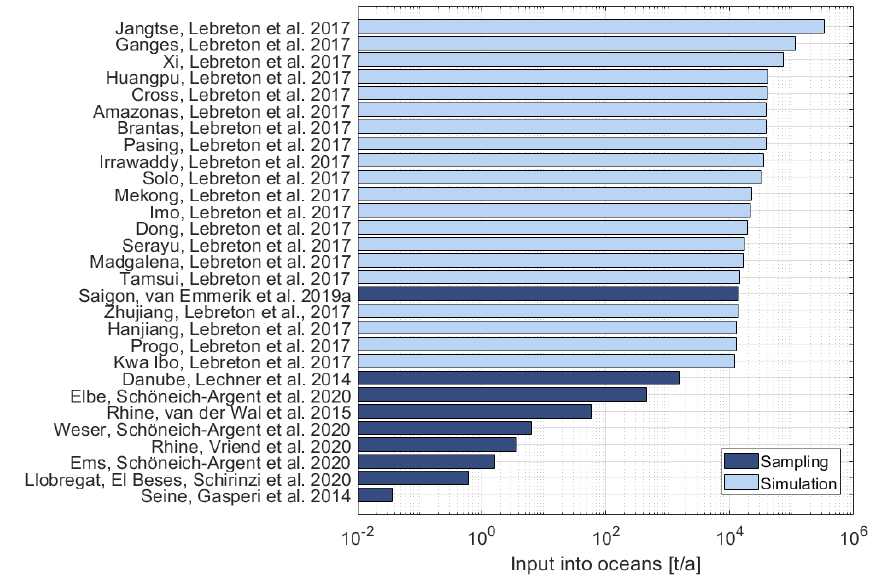
Figure 4. Annual input into oceans of average riverine, floating macroplastic (MaP) differentiated according to data from modelling and sampling (data based on [5,51,118,128–132].